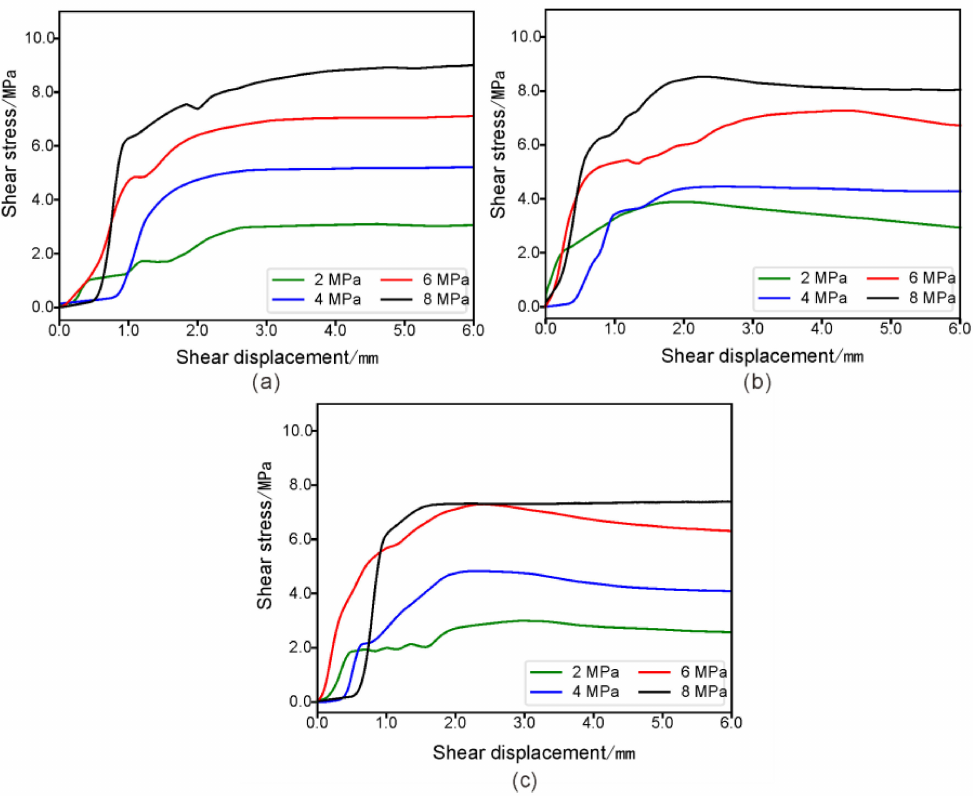
Figure 11. The shear stress–shear displacement curves for shear fault surface filled with 3 types of fault gouge (( a ) is No. 1 fault gouge, ( b ) is No. 2 fault gouge, and ( c ) is No. 3 fault